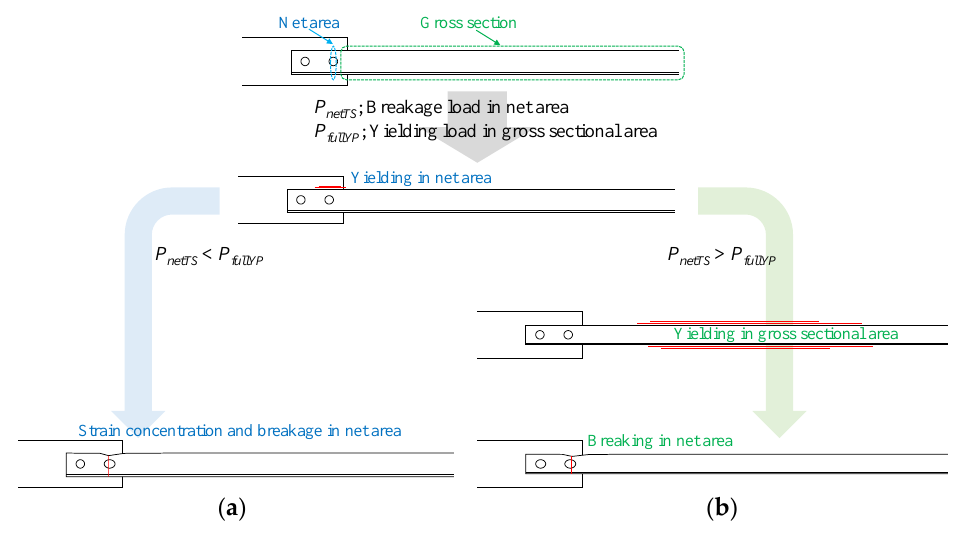
Figure 5. Plastic behavior of steel brace: ( a ) lack tensile strength brace; ( b ) enough tensile strength brace.